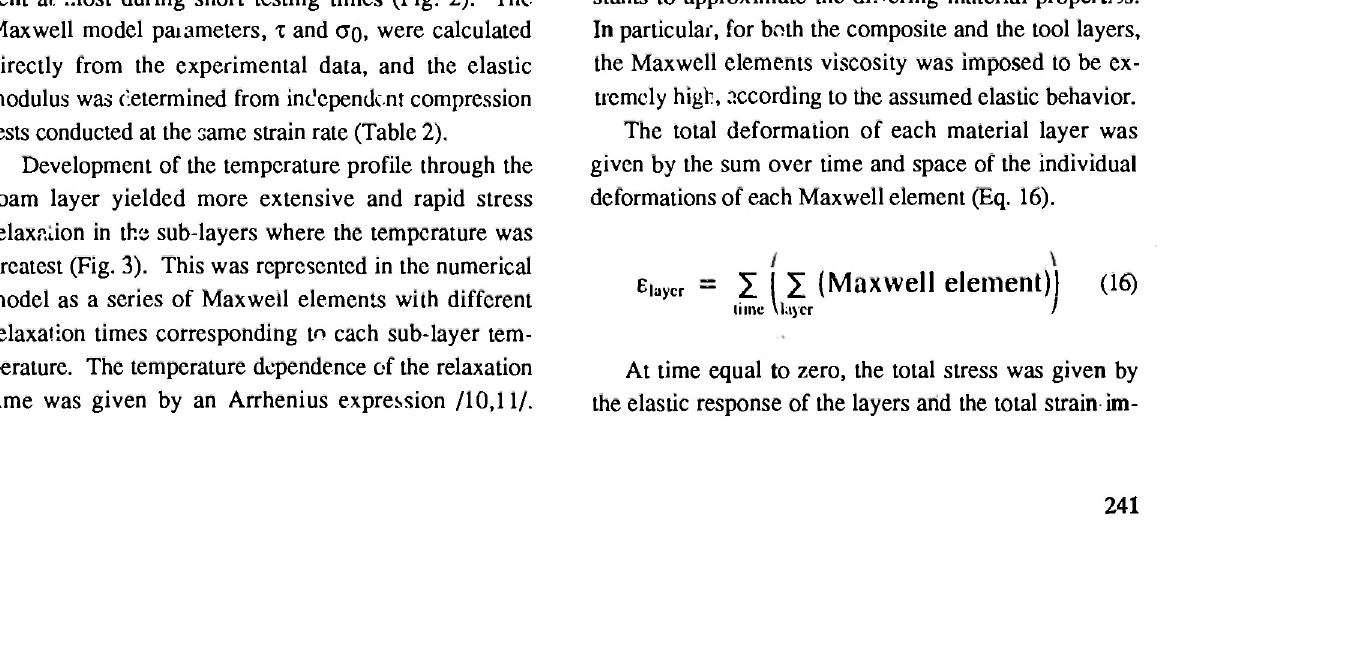
Maxwell parameters and compressive moduli for the polyurethane (PU) and expanded polystyrene (EPS) foams.